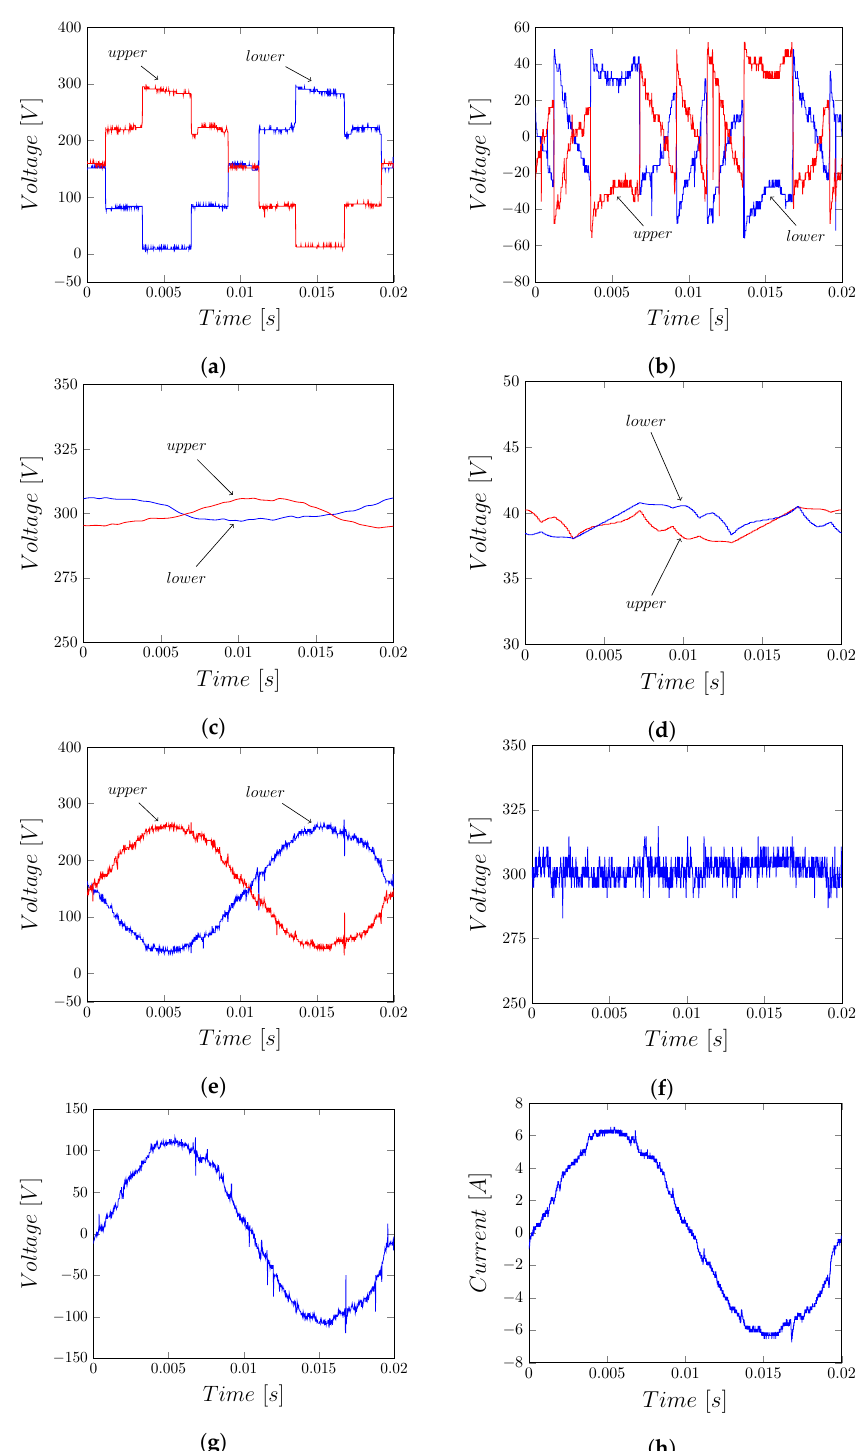
Figure 4. EMMC experimental results: ( a ) HB chain-link voltage; ( b ) FB chain-link voltage; ( c ) HB chain-link total capacitor voltage; ( d ) FB chain-link total capacitor voltage; ( e ) total arm voltage; ( f ) common-mode voltage; ( g ) output AC voltage; ( h ) output AC